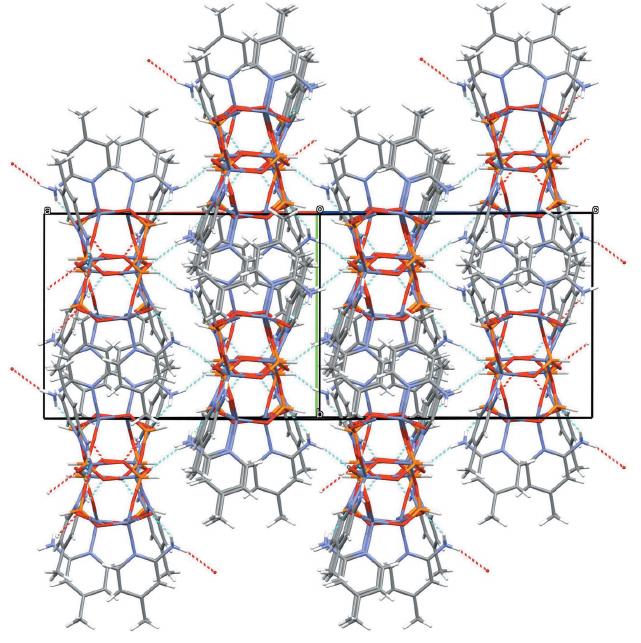
Figure 10 The unit-cell packing in (III) viewed down [100]. Hydrogen bonds are shown as dashed lines.